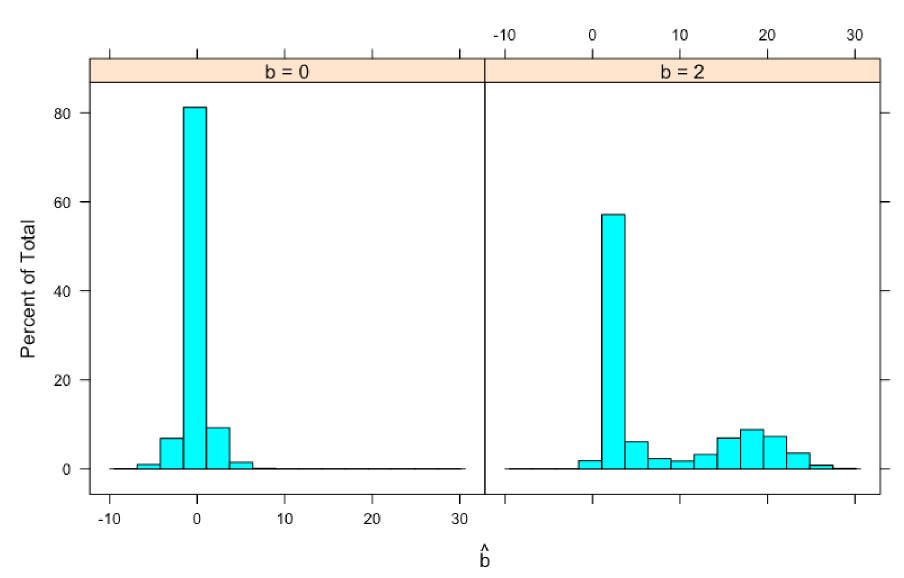
Figure 2. Histogram of simulated ˆ b = y / ˆ µ x , the MLE of b . Data simulation procedure is described in the